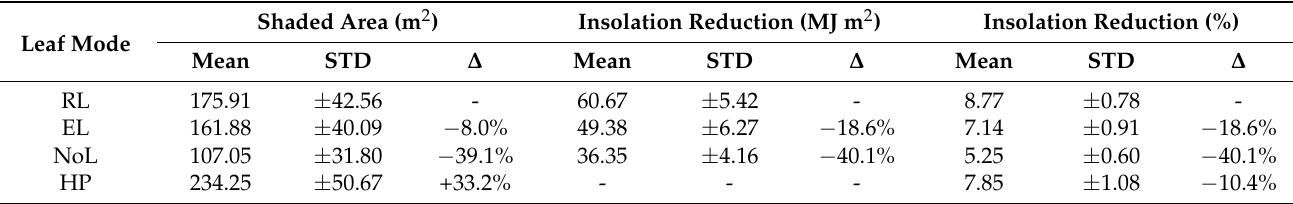
The mean shading effects are presented in Table 4. Shaded area for HP were greater in size compared to the QSM-based leaf modes. The respective minimum and maximum shaded areas were: 181.15 m 2 ( Pa_6 HP), and; 316.93 m 2 ( Pa_5 HP). Table 4. Shading effect parameters for the leaf modes and alternative method: average values, standard deviation (STD) and mean deviation in percent ( ∆ ), compared with RL.